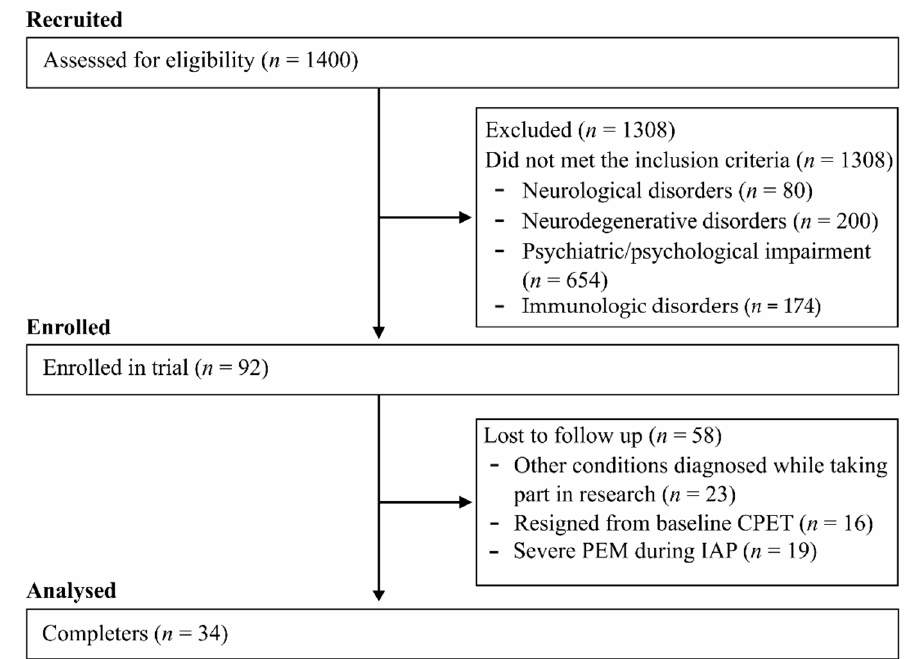
Figure 1. CONSORT-type flow diagram.